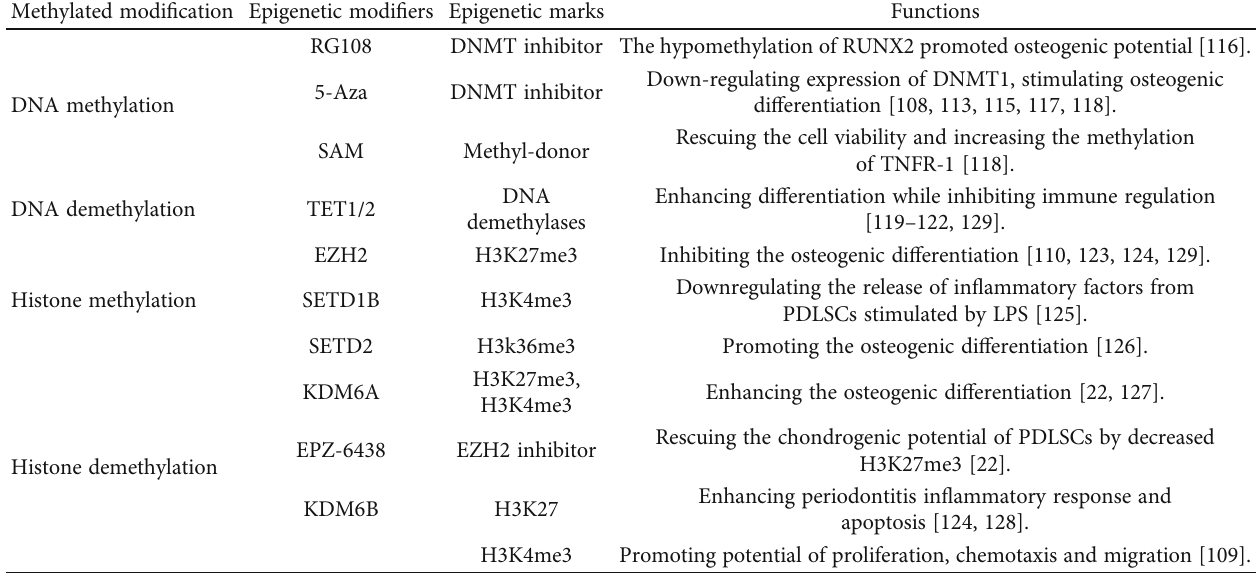
Table 1: Methylation and demethylation in